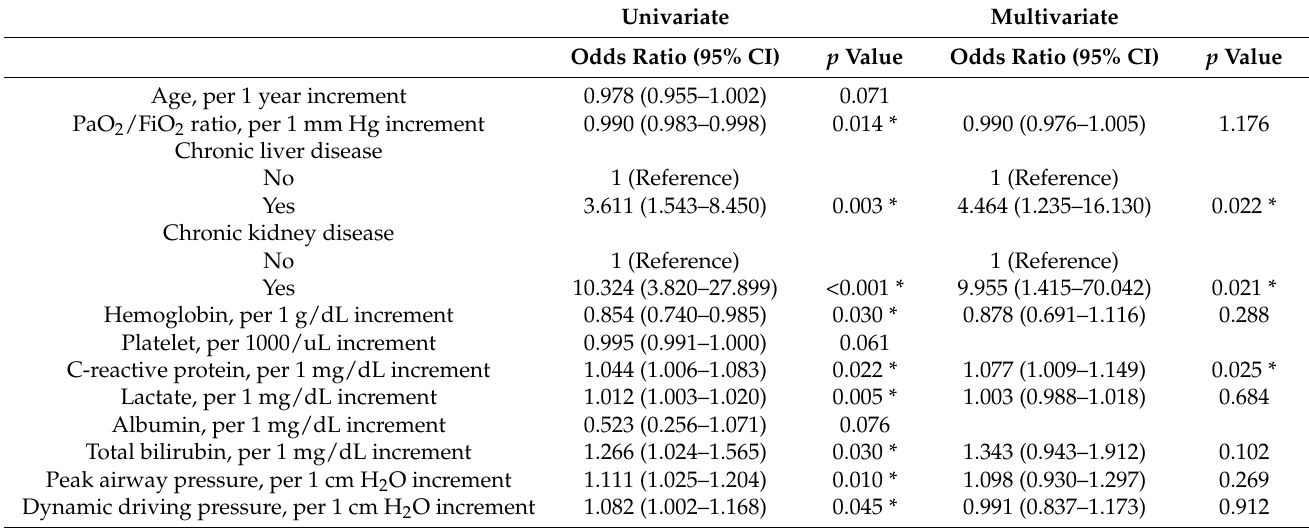
Table 5. Predictive factors for acute kidney injury requiring RRT.